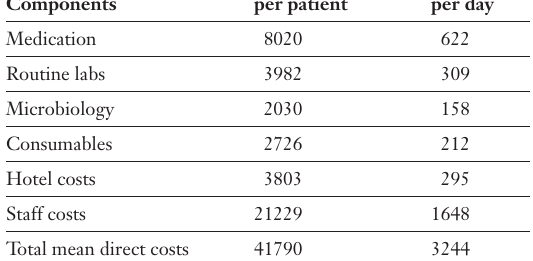
population was 62 years (± 15.0). The majority of patients, i.e. 57.4%, were male and 42.6% were fe- male. An overall ICU mortality of 49.2% was ob- served and an overall average length of stay (LOS) in the ICU of 12.9 days (± 9.9). Survivors and non-